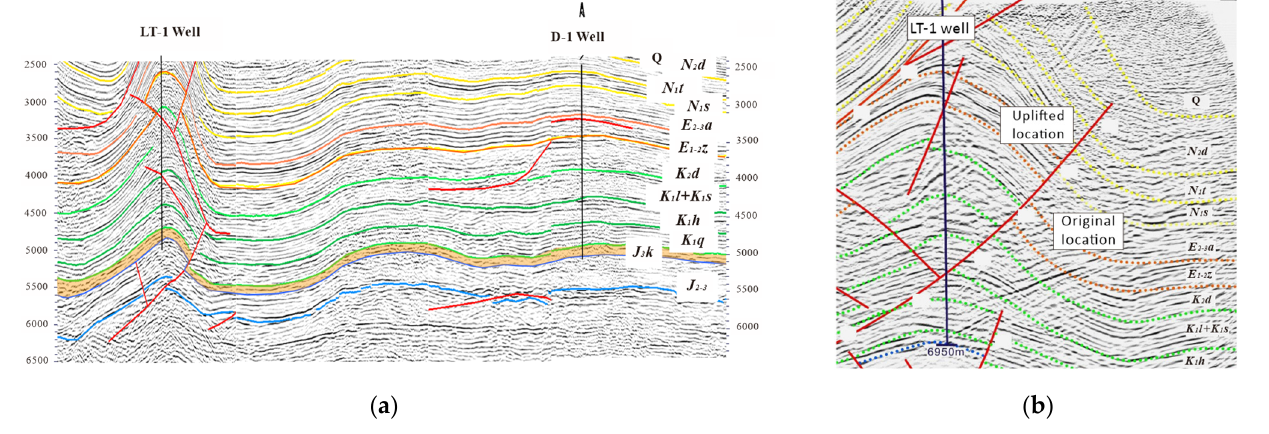
Figure 2. ( a ) Profile and structure of a main survey line of Tugulu anticline of TS Block. ( b ) A sec ‐ tional view of a survey line across well LT ‐